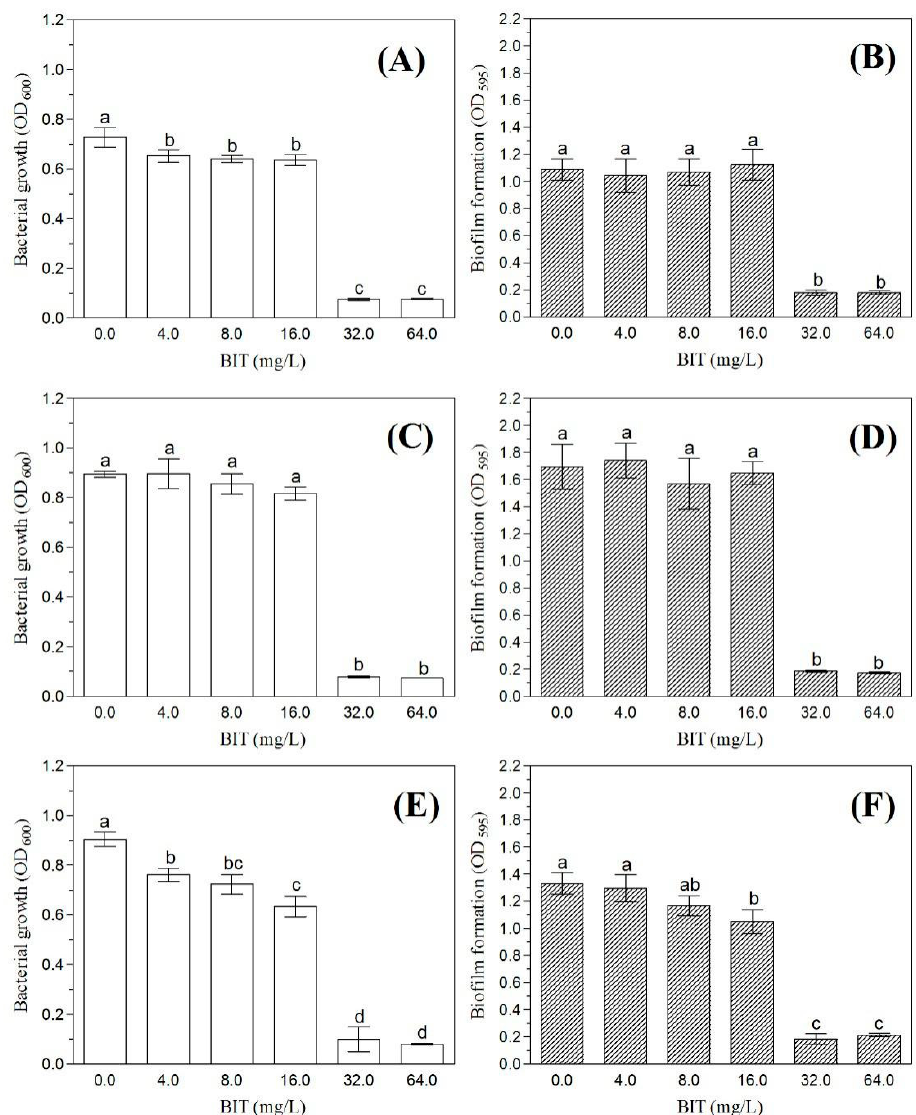
Figure 4. Planktonic growth and initial biofilm formation of C. werkmanii BF-6 ( A , B ), ∆ ttcA ( C , D ) and ∆ ttcA -com ( E , F ), respectively. The strains were grown in LB medium supplemented with indicted concentrations of BIT. All assays were conducted in triplicates and the columns marked with different letters (a, b, c or d) indicate that they are significantly different from each other according to Fisher’s LSD test ( p < 0.05), calculated with the DPS data processing software.